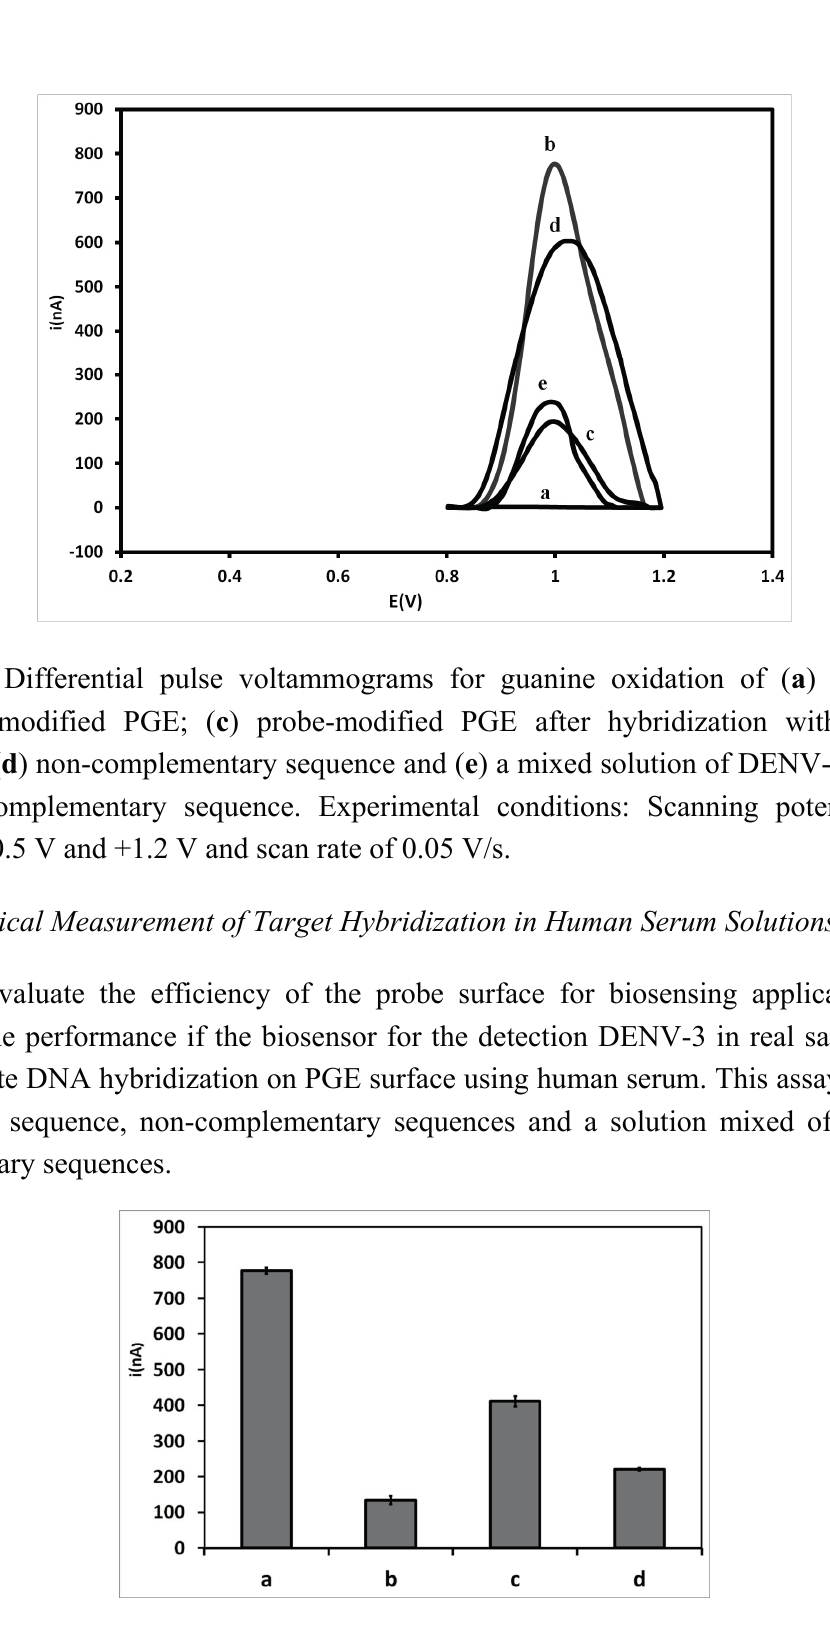
Figure 6. Current peaks related to guanine oxidation of the probe-modified-PGE after ( a ) and before hybridization with DENV-3 ( b ); in the presence of non-complementary sequences ( c ) and in a solution mixed with DENV-3 and non-complementary sequences ( d ), all diluted in human serum. Experimental conditions: Scanning potential range between +0.5 V and +1.2 V and scan rate of 0.05